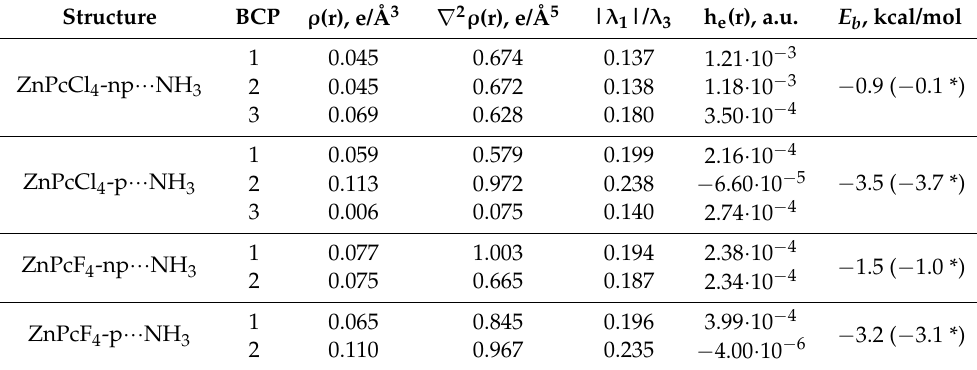
Figure 9. Geometric structure of ZnPcHal 4 … NH 3 aggregates. Small green balls show the positions of the bond critical points (3, − 1) (the points indicating the formation of a bond between phthalocyanine and ammonia are highlighted in red). Table 3. Topological parameters of the ρ ( r ) function in the bond critical points between atoms of ammonia and ZnPcHal 4